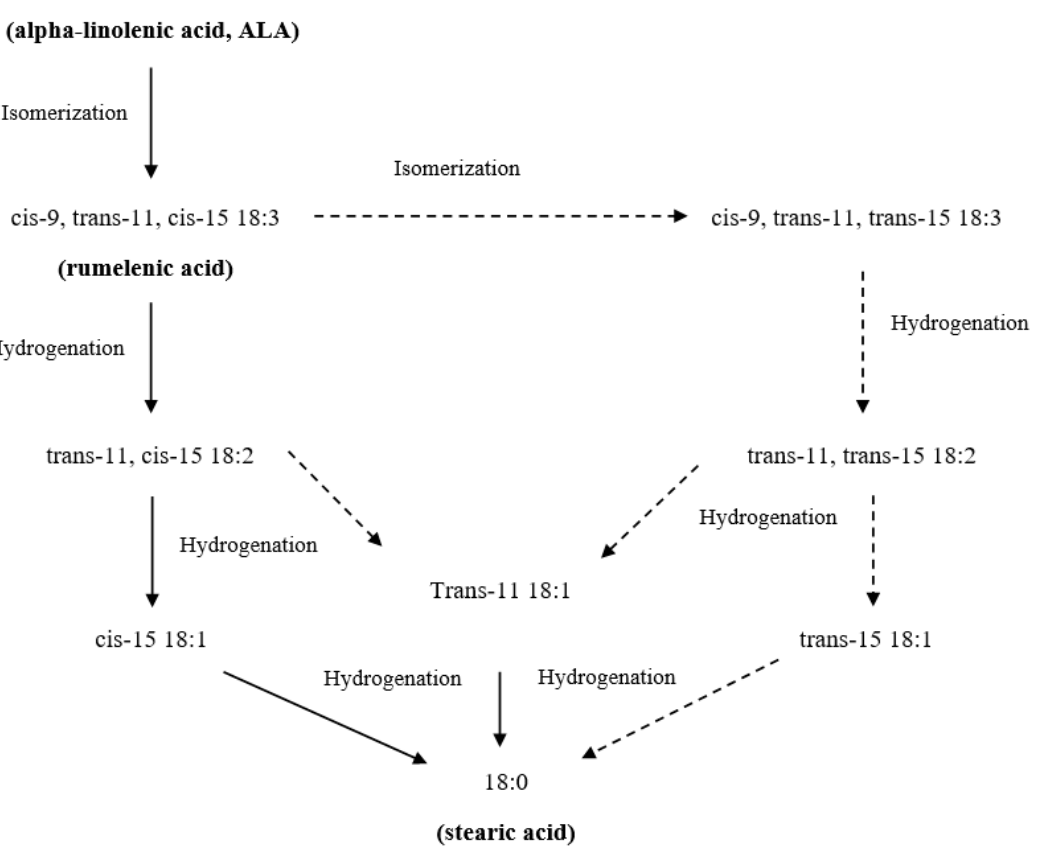
Figure 4. Ruminal biohydrogenation of alpha-linolenic acid. Thick arrows represent the major pathway; dotted lines with arrows represent putative pathway (adapted from Gomez-Cortes et al. [108]).